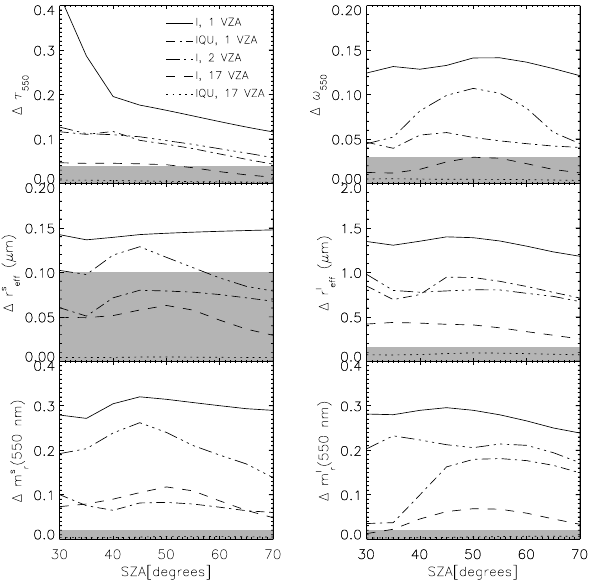
Fig. 3. As in Fig. 2, but for retrievals with unknown surface proper- ties, and only considering multiple-viewing-angle